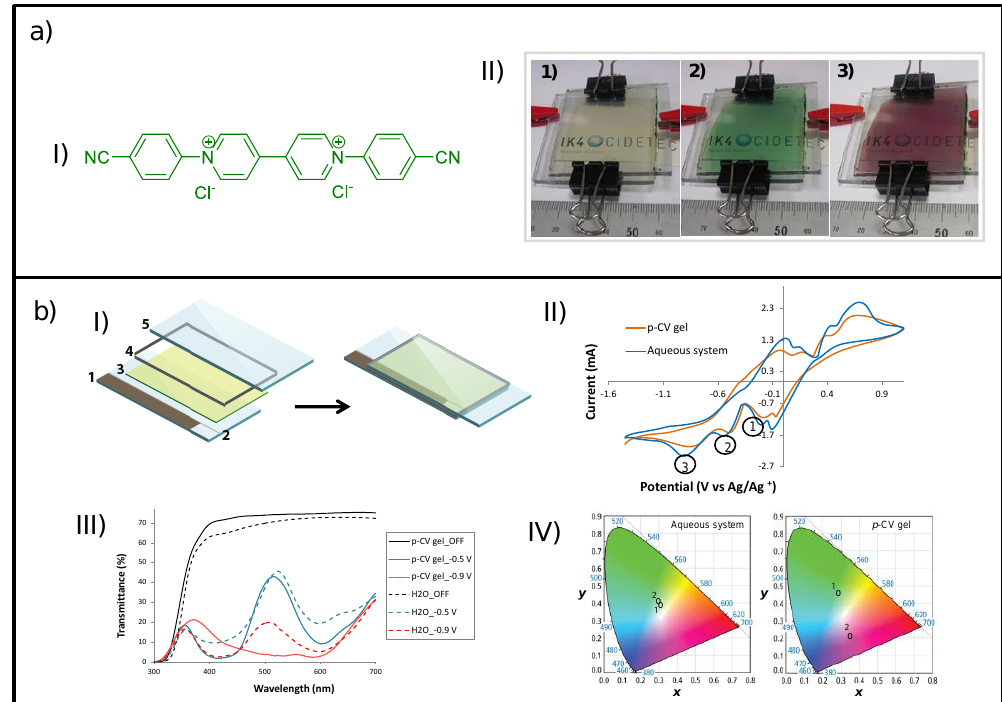
Figure 7. ( a ) Two-electrode ECD: ( I ) Chemical structure of p- cyanophenyl viologen dichloride ( p -CV); ( II ) photographs of an electrochromic device containing p -CV viologen in (1) bleached state, and colored states at switching voltages of ( 2 ) −1.4 V and ( 3 ) −1.8 V. ( b ) Gel-type ( p -CV gel) vs. aqueous liquid system (H 2 O) in three-electrode ECD configuration: ( I ) Schematic illustration of the three-electrode ECD configuration including ( 1 ) Ag/Ag + pseudoreference electrode, ( 2 ) laser scribing, ( 3 ) EC gel, ( 4 ) spacers, and ( 5 ) TCO/glass; ( II ) cyclic voltammograms at a scan rate of 30 mV/s; ( III ) UV-Vis transmittance response in bleached state and upon applying −0.5 V and −0.9 V voltages; ( IV ) Commission Internationale de I'Eclairage CIE color space plots representing the color coordinates of devices containing aqueous system (left) and p -CV gel (right) upon applying ( 1 ) −0.5 V and ( 2 ) −0.9 V. Adapted with permission from [149], copyright (2016) American Chemical Society.